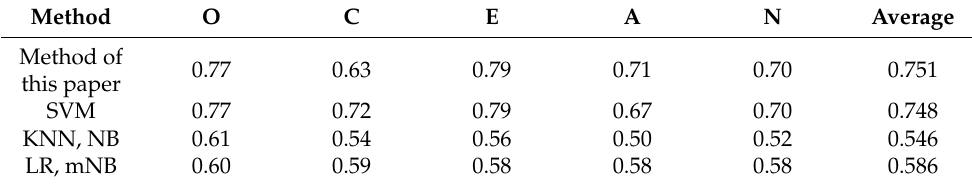
Table 9. Comparison of F1